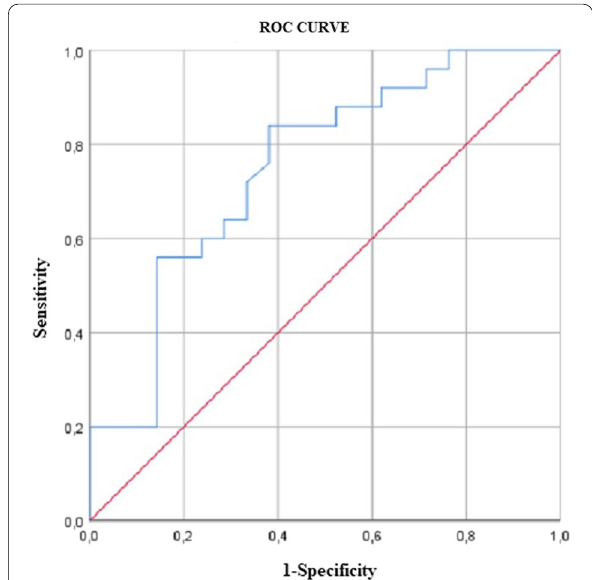
Fig. 2 ROC curve analysis between prostate cancer and control group. The area under the curve (AUC) was 0.751 (95% CI 0.608– 0.895) for LL37 ( p 0.004) =